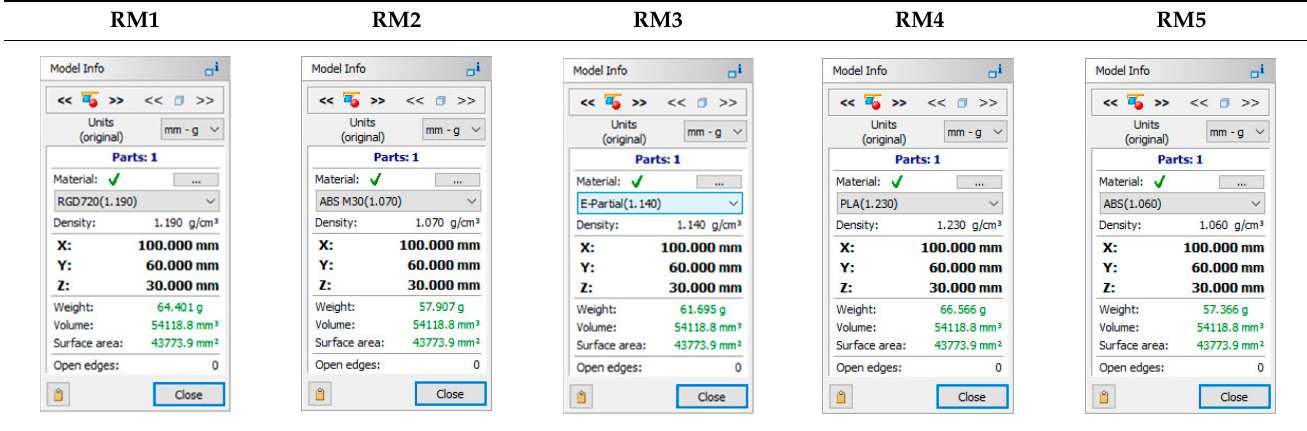
260V, 3D STRATASYS F170, EnvisionTEC Vida, Prusa i3 MK3, and UP